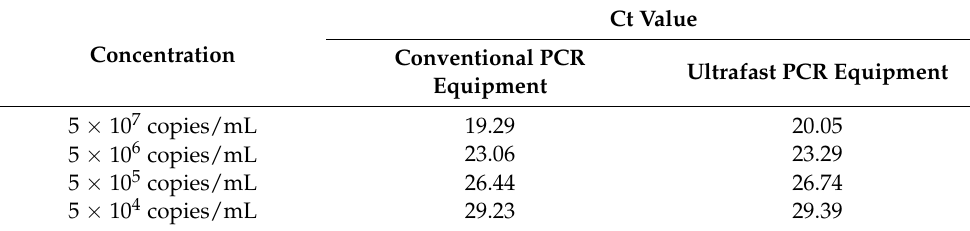
Figure 5. Results of four concentration gradient samples on conventional PCR equipment (HONGSHI) and ultrafast PCR equipment. The concentration from high to low is represented by four color curves of black, green, orange and magenta respectively. The Ct value and fitting line shows their correlative coefficients are 0.9956 and 0.9972 respectively. Table 2. Ct value of four concentration gradient